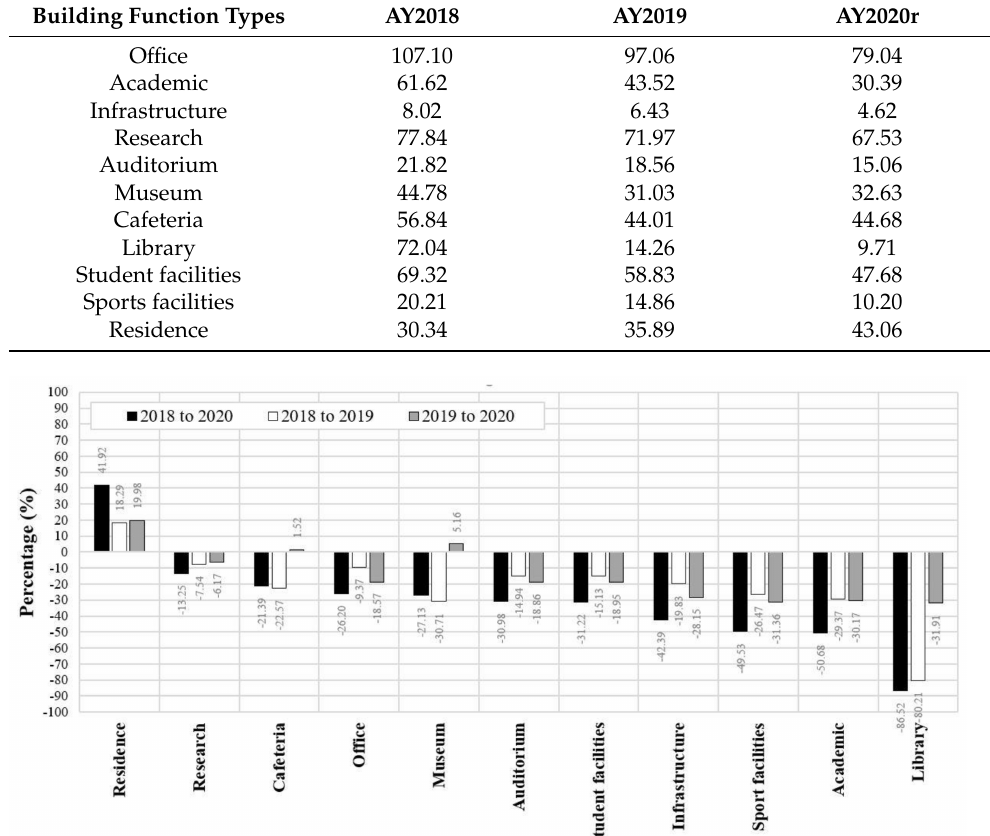
Table 4. The Energy Use Index (kWh/m 2 -y) based on buildings function types during the typical